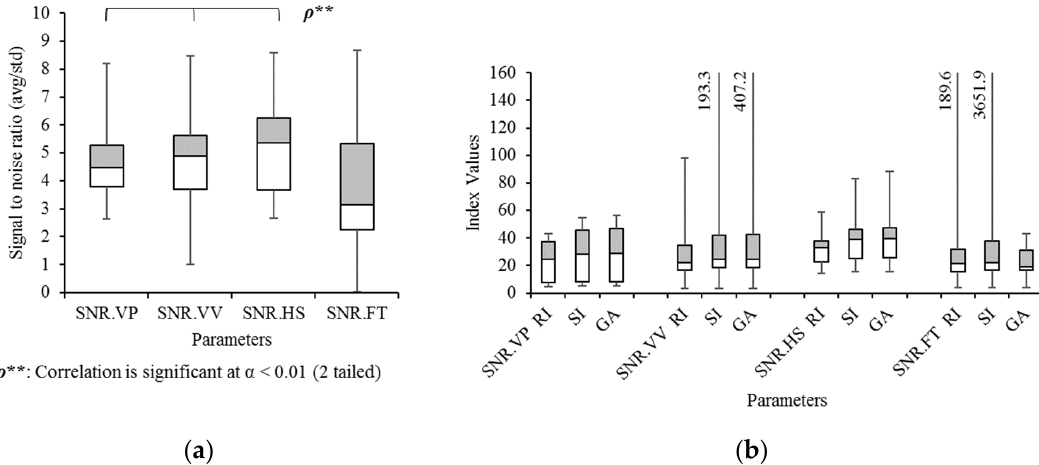
Figure 12. Box and Whisker diagrams of signal to noise ratio (SNR) with ( a ) the average values and ( b ) gait symmetry indices in four different measurement methods.